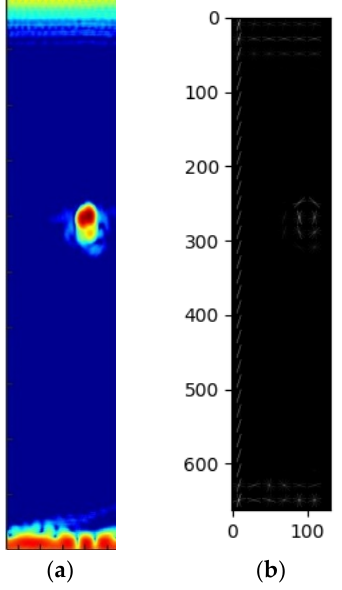
Figure 6. ( a ) Original image; ( b ) HOG feature of TFM image.